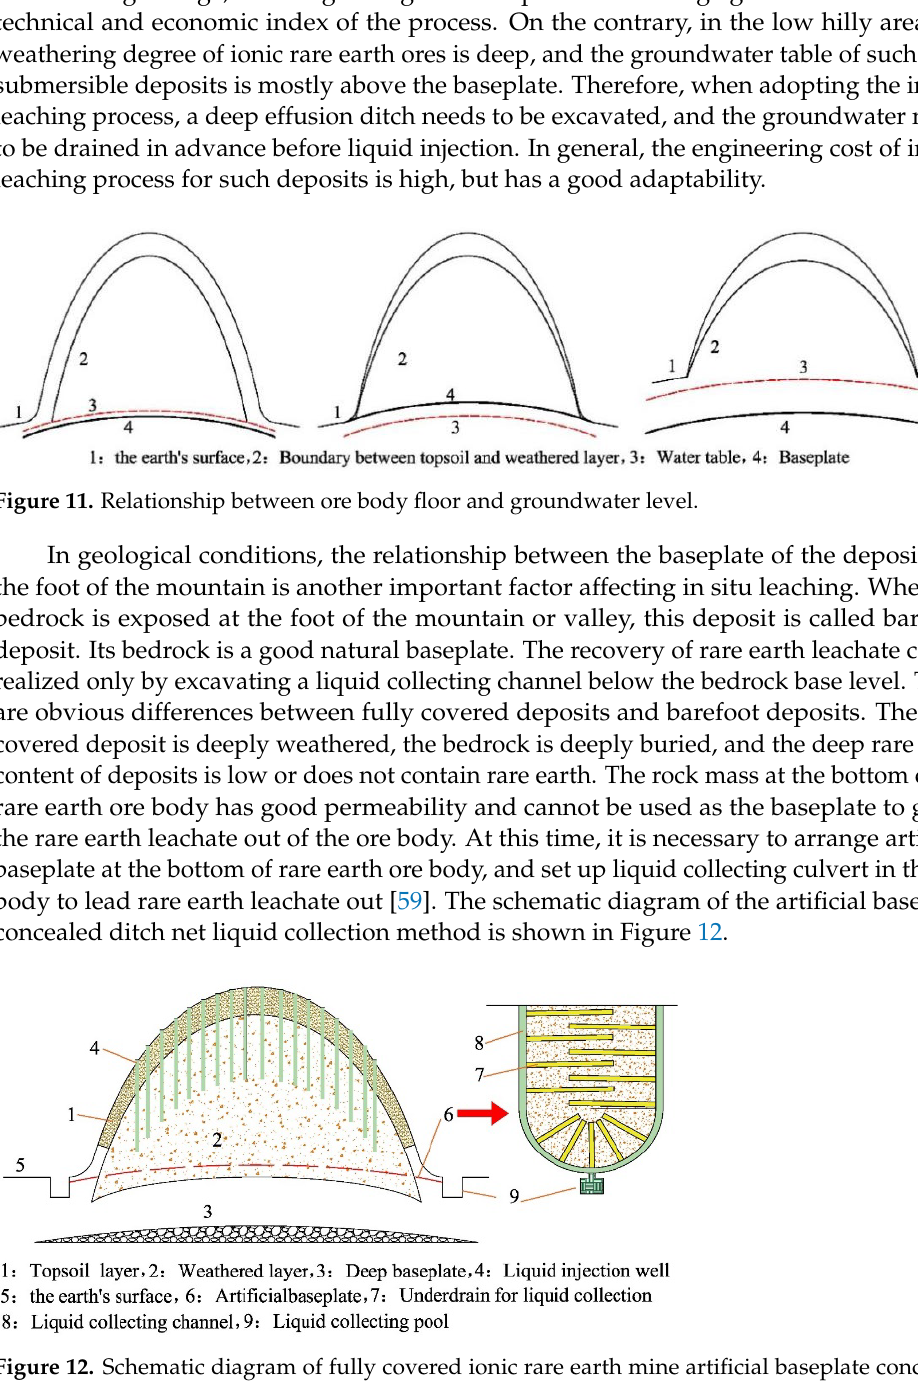
Figure 11. Relationship between ore body floor and groundwater level.